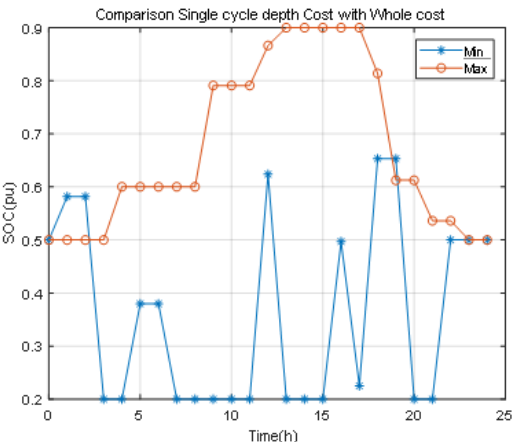
Figure 3. Life-cycle cost comparison flowchart for cycle approximation.